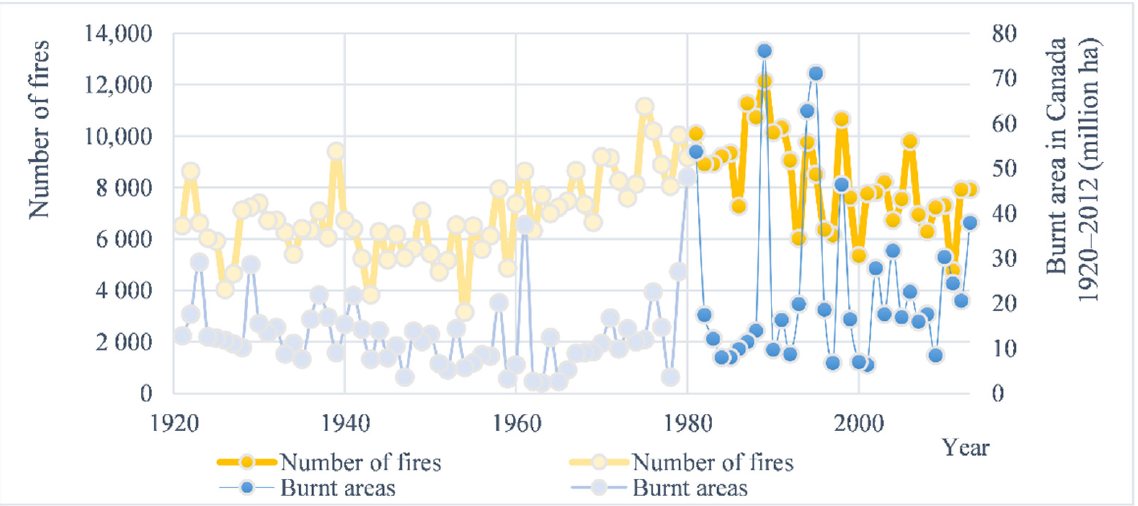
Figure 2. The evolution of wildfires in Canada (1920–2013). Data before 1980 are impacted by larger uncertainty (lack of satellite vision) and are depicted in gray.